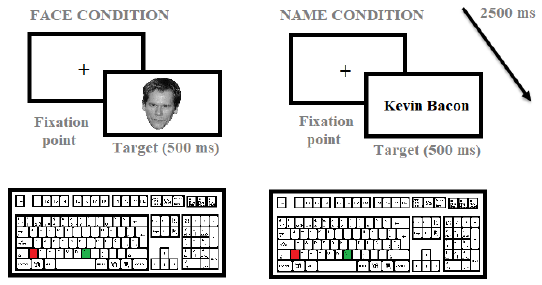
Figure 1. Visual representation of the experimental setup and conditions.